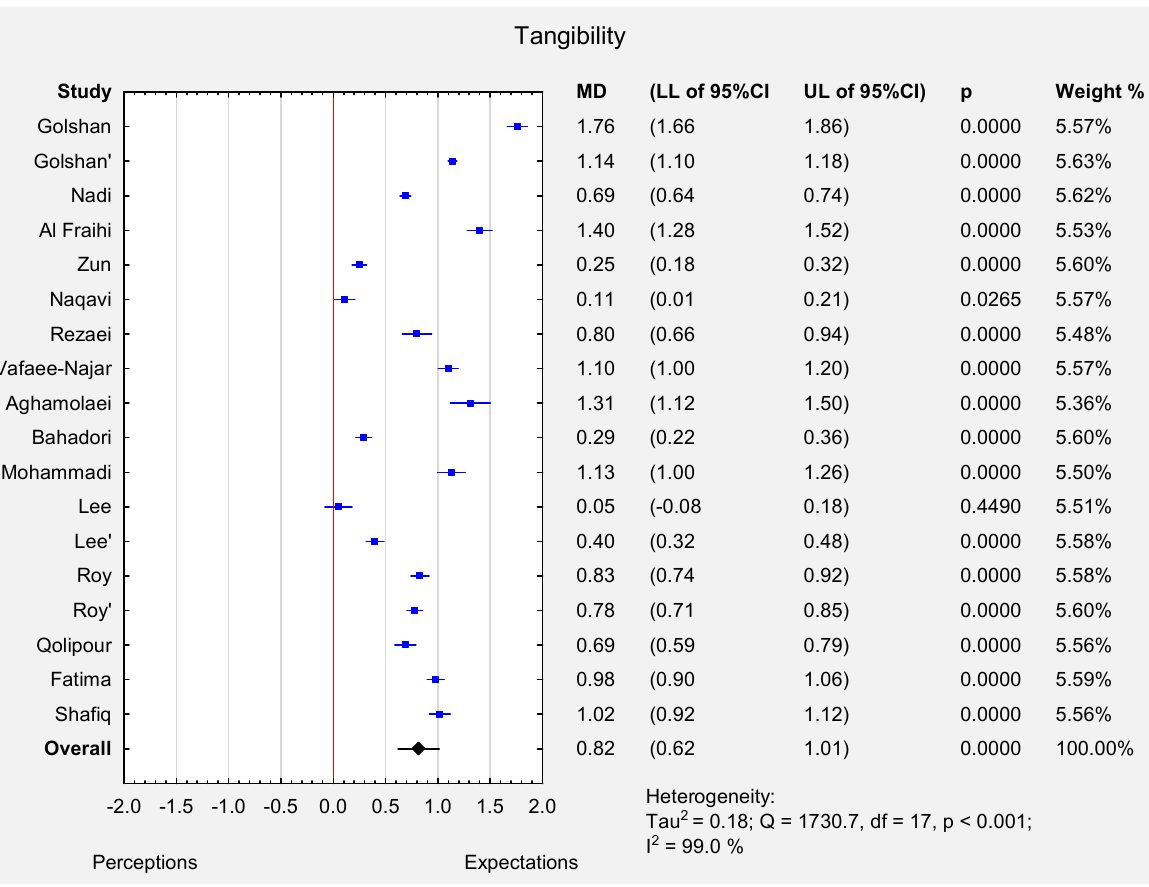
Figure 2. Forest plot for the mean difference ([MD]; 95% CI) of patients’ perceptions and expectations of tangibility dimension.